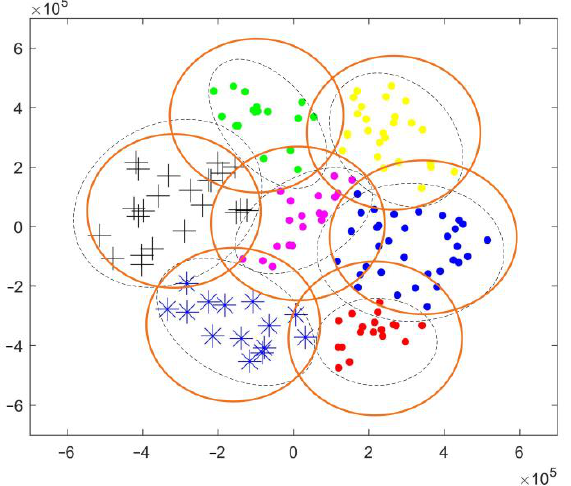
Figure 5. Schematic diagram of multibeam coverage with 7 multicast groups.